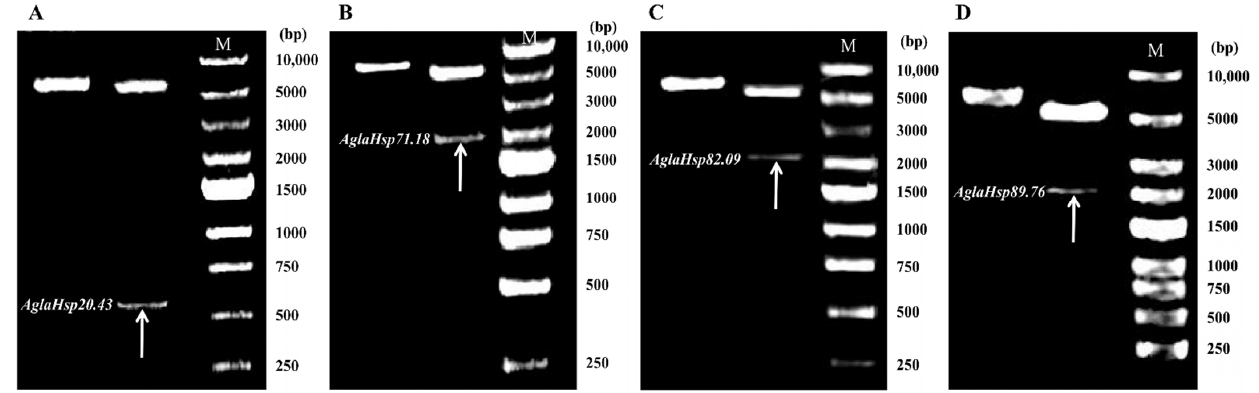
Figure 3. Recombinant plasmids pET30a ‐ AglaHsps and their double digestion products. On each panel, the left band represents the intact recombinant plasmid pET30a ‐ AglaHsps , and the right band shows the digested products, plasmid pET30a and full ‐ length CDS of AglaHsp20.43 ( A ), AglaHsp71.18 ( B ), AglaHsp82.09 ( C ), and AglaHsp89.76 ( D ), with their signal peptide regions removed. Target genes are indicated with arrows. M: DNA fragment size marker (DNA Ladder 250–10,000 bp).